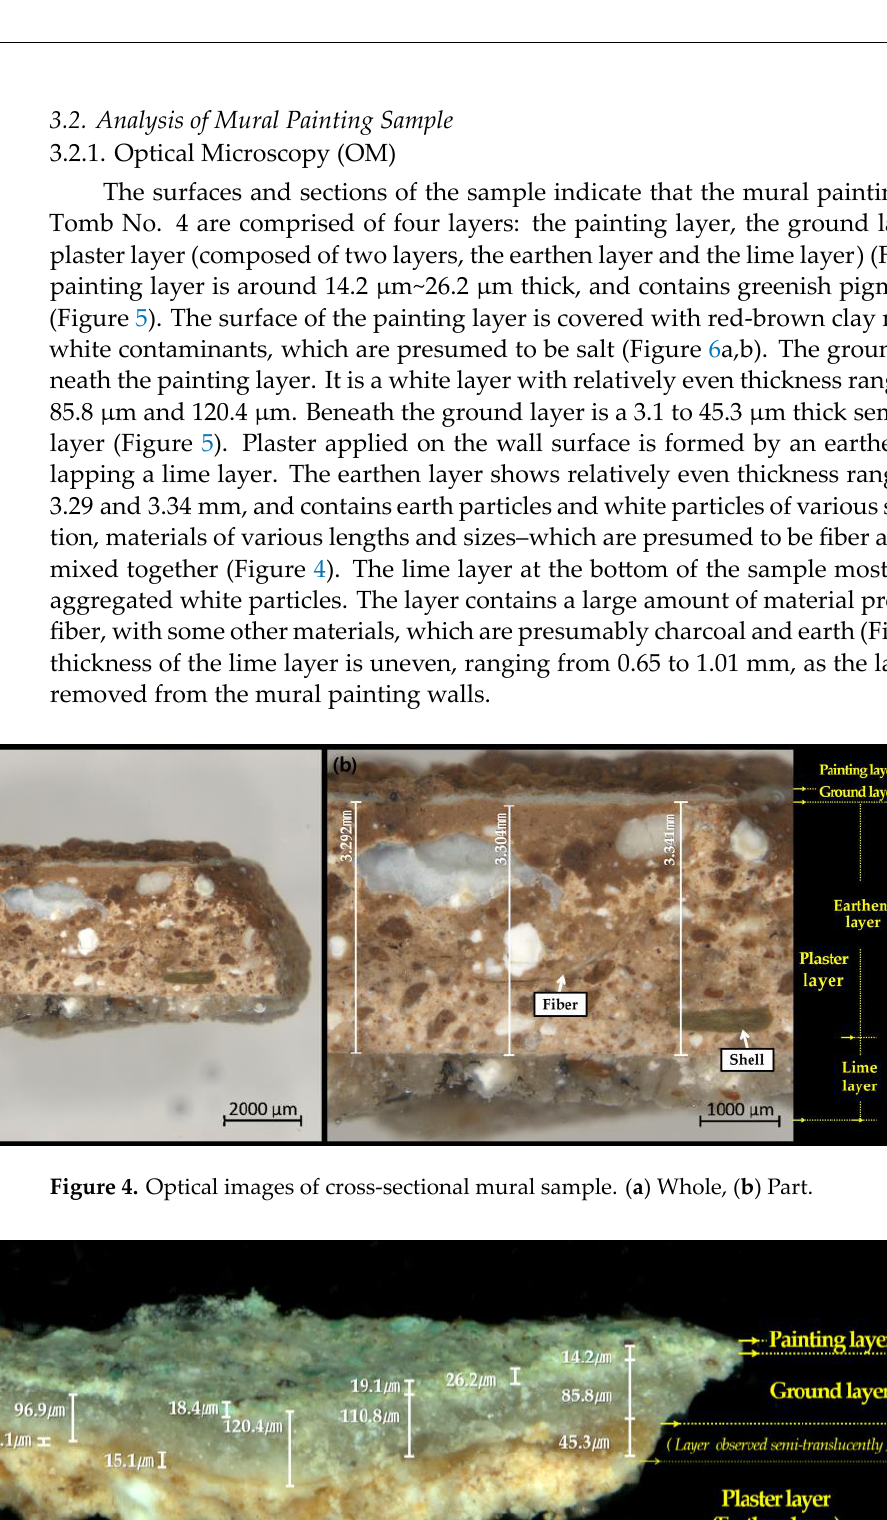
Figure 3. Status of murals in the Jinpari Tomb No. 4. ( a ) West side of burial chamber. ( b , c ) Mural painting details (West side on corridor floor).